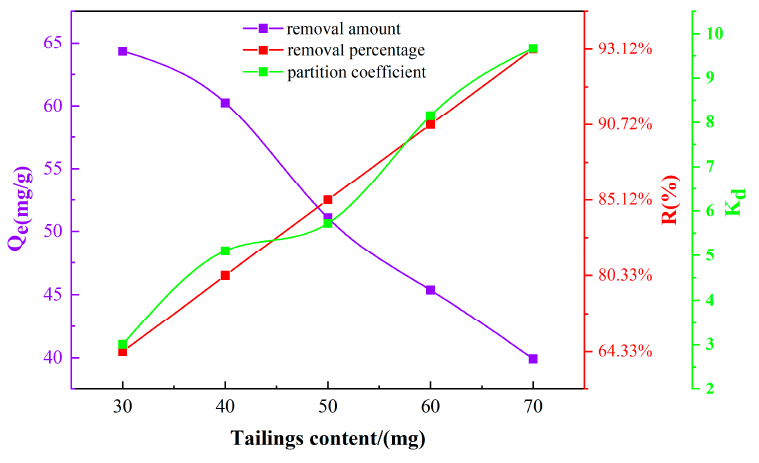
Figure 8. Effects of iron tailings’ mass on the adsorption of GO.